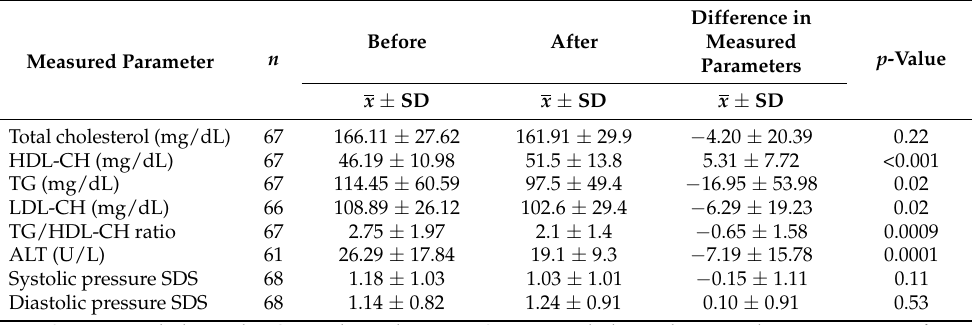
Table 3. Changes in lipid profile parameters and blood pressure before and after the dietary interven-